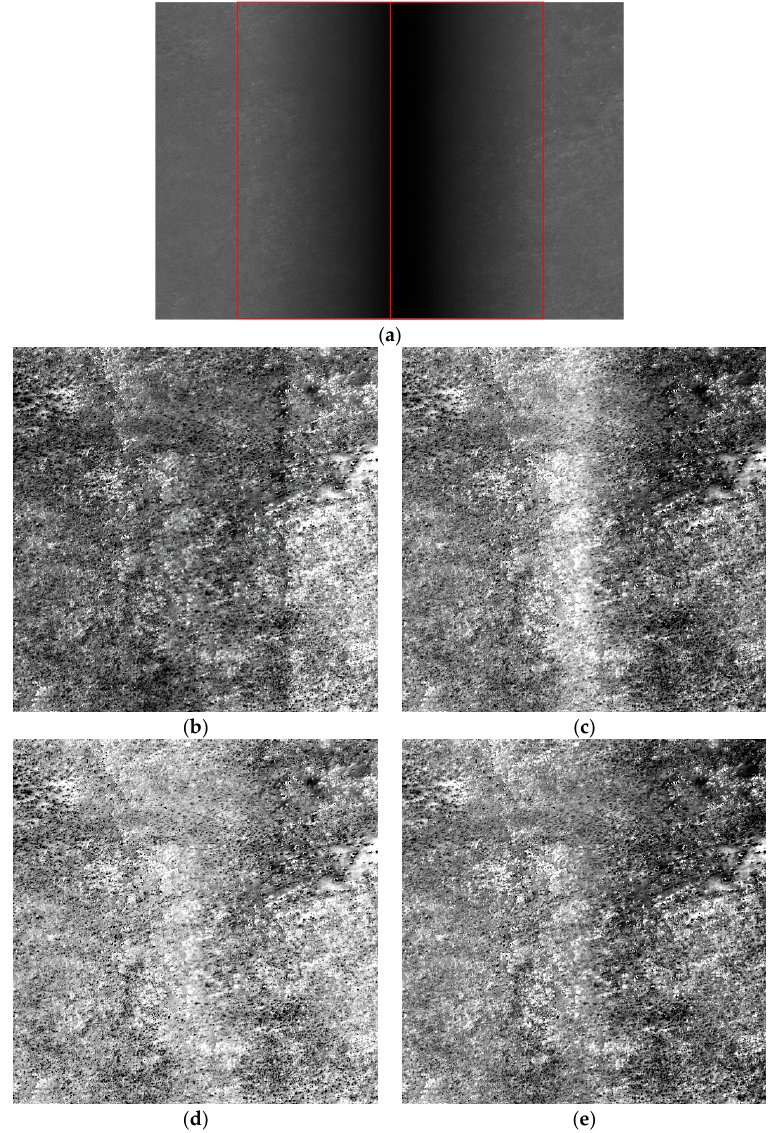
Figure 19. Raw and corrected images of the hill (the images were stretched for display): ( a ) raw image; ( b ) image corrected using the polynomial fitting; ( c ) image corrected using the laboratory coefficients; ( d ) image corrected using the on-orbit coefficients; ( e ) image corrected using the proposed method.